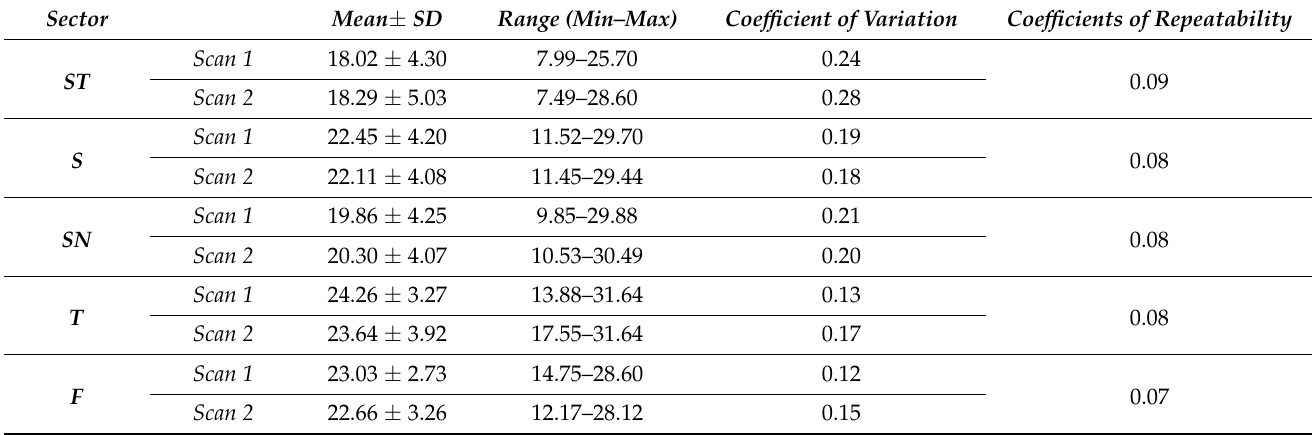
Table 4. ICP vessel density